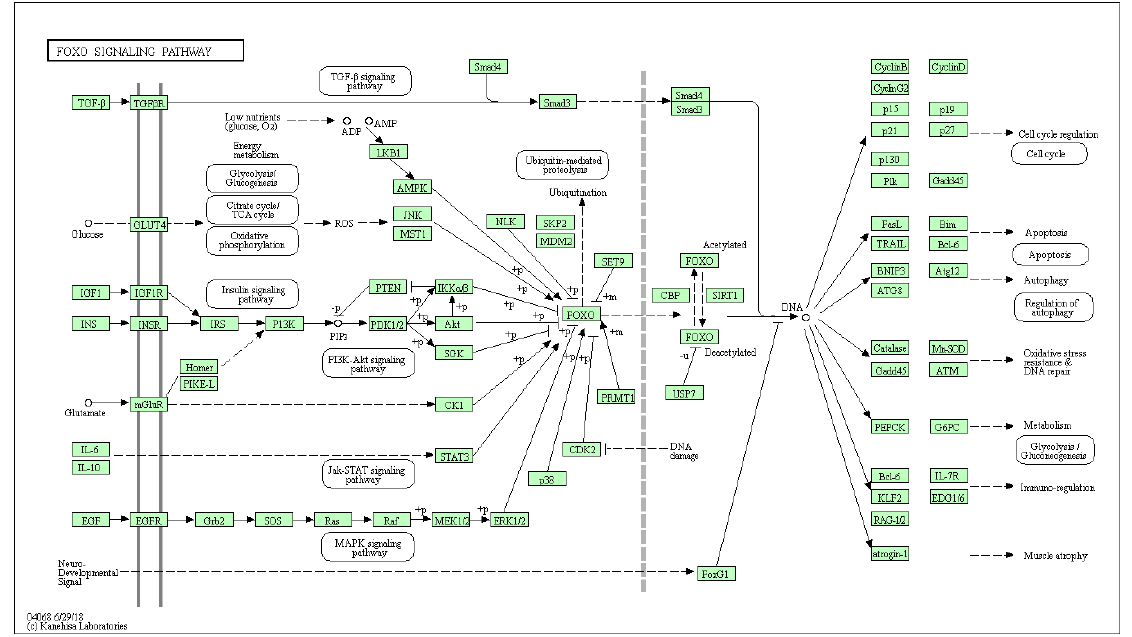
Figure A6. FOXO signaling pathway, KEGG pathway. KEGG, Kyoto Encyclopedia of Genes and Genomes. Copyright permission obtained.